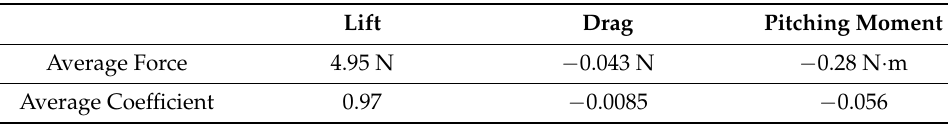
Table 3. Average aerodynamic coefficients (c.g =